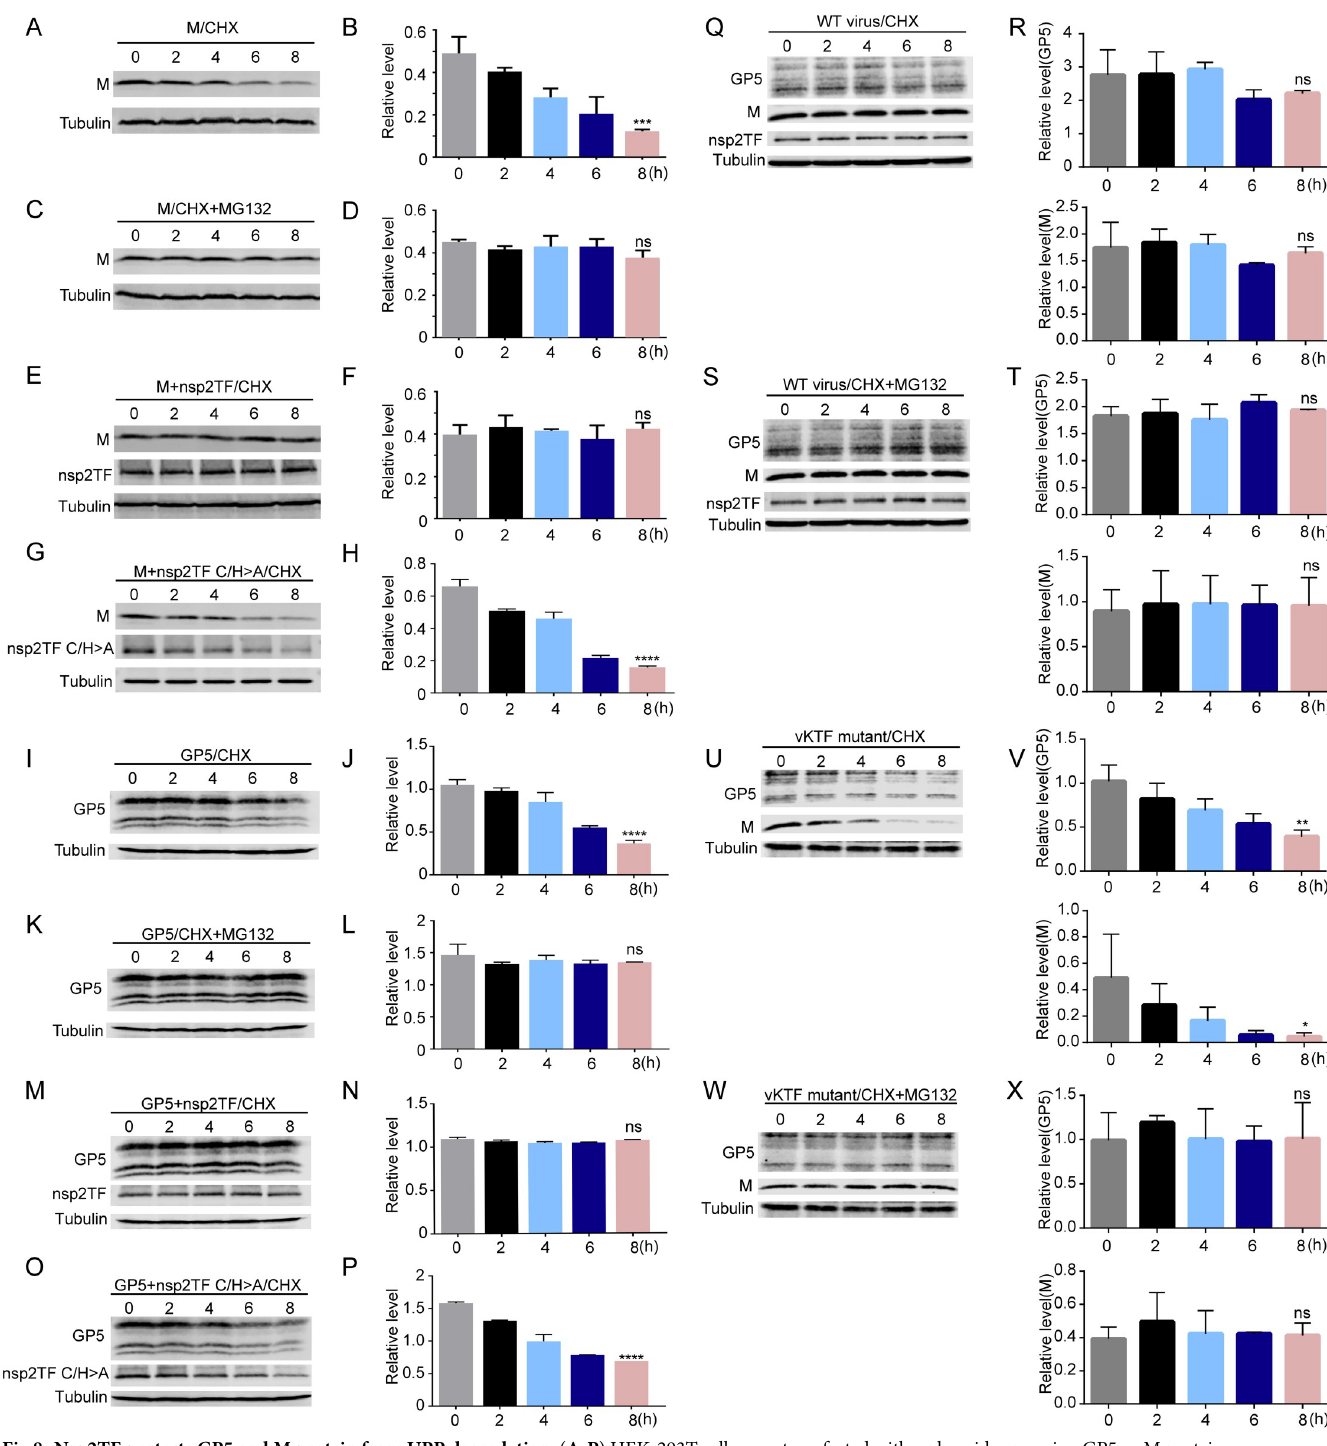
Fig 8. Nsp2TF protects GP5 and M protein from UPP degradation. ( A-P ) HEK-293T cells were transfected with a plasmid expressing GP5 or M protein, or co- transfected with plasmids expressing the nsp2TF (or its mutant nsp2TF C/H > A) and GP5 or M protein. At 24 h post-transfection, transfected cells were treated with CHX alone or in combination with the proteasome inhibitor MG132. For each transfection condition, cells were collected every 2 h after the drug treatment. The whole cell lysates were used for Western blot analysis. Nsp2TF, GP5 and M protein expression were detected with anti-nsp2TF pAb, anti-M pAb and anti-GP5 mAb. β -tubulin was included as a loading control. ( B, D, F, H) Relative protein expression levels of M protein under the corresponding experimental condition in the left panels A, C, E, G, respectively. (J, L, N, P ) Relative protein expression levels of GP5 under the corresponding experimental condition in the left panels I, K, M, O, respectively. ( Q, S, U,